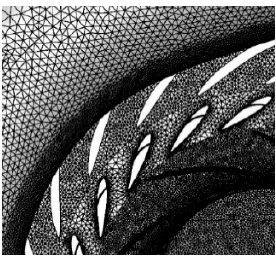
Figure 3. Meshing Figure 3. Meshing scheme.